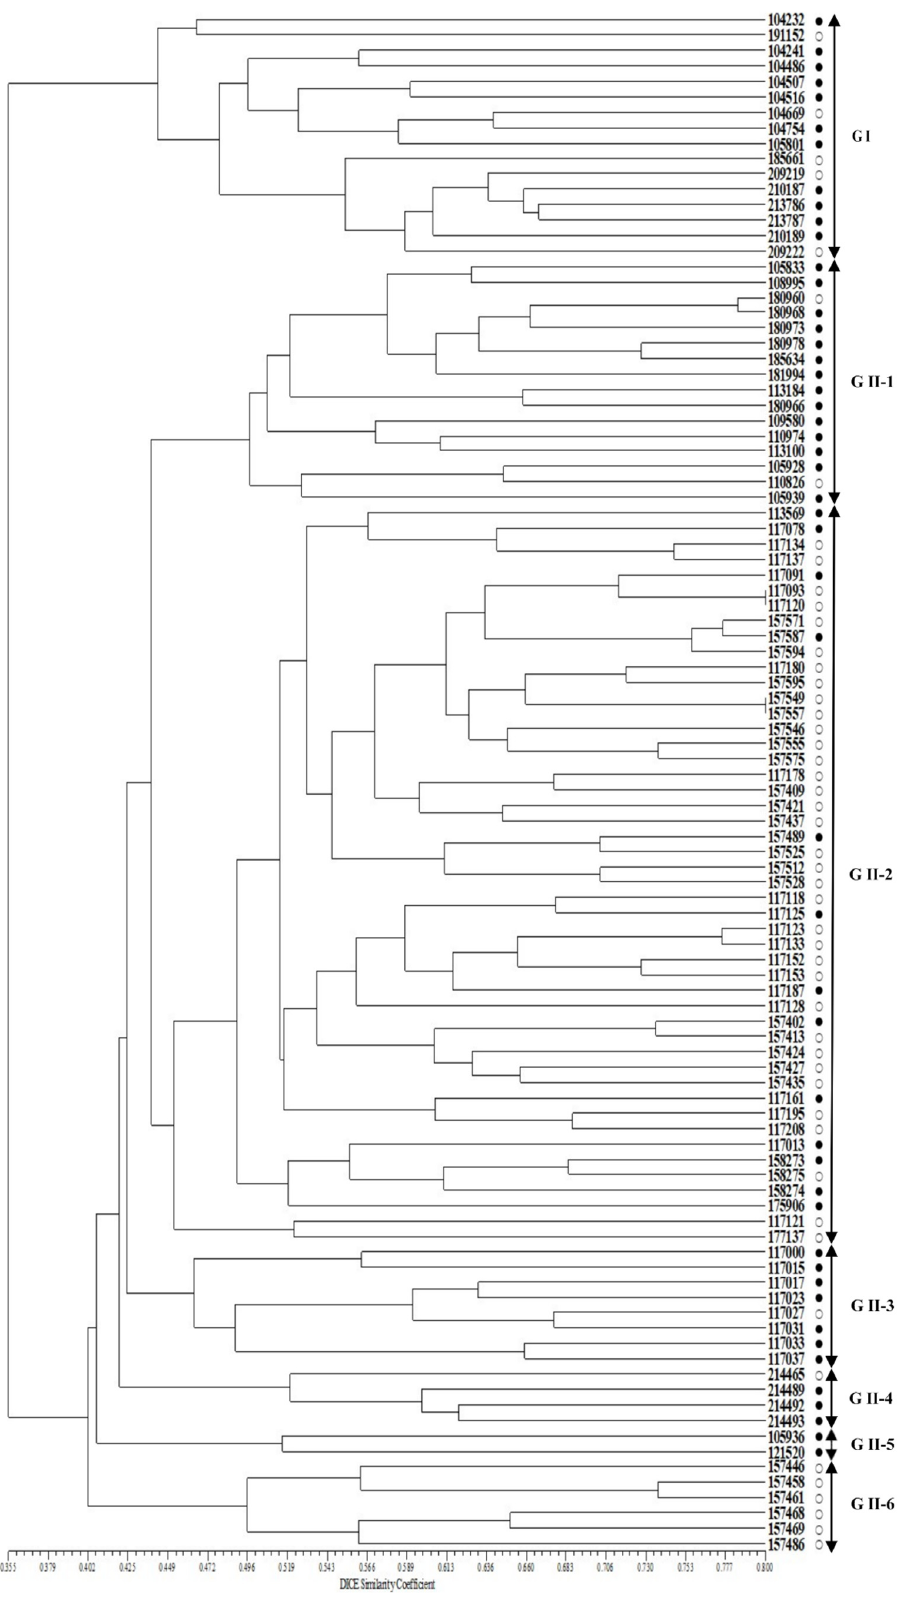
Figure 3. UPGMA dendrogram of 100 accessions of cultivated var. frutescens based on 40 SSR markers. ○ : accessions of cultivated var. frutescens with a low total fatty acid content, ● : accessions of cultivated var. frutescens with high total fatty acid content.